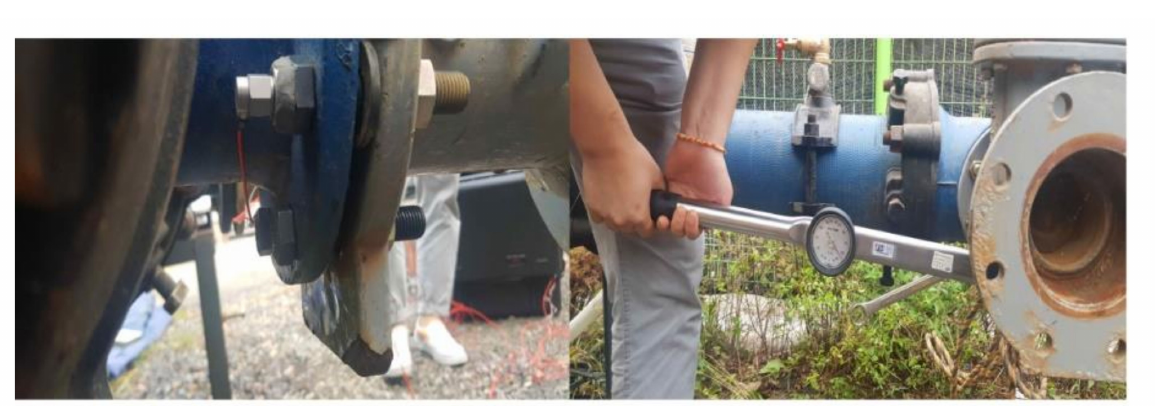
Figure 6. Smart bolt installation and measurement of